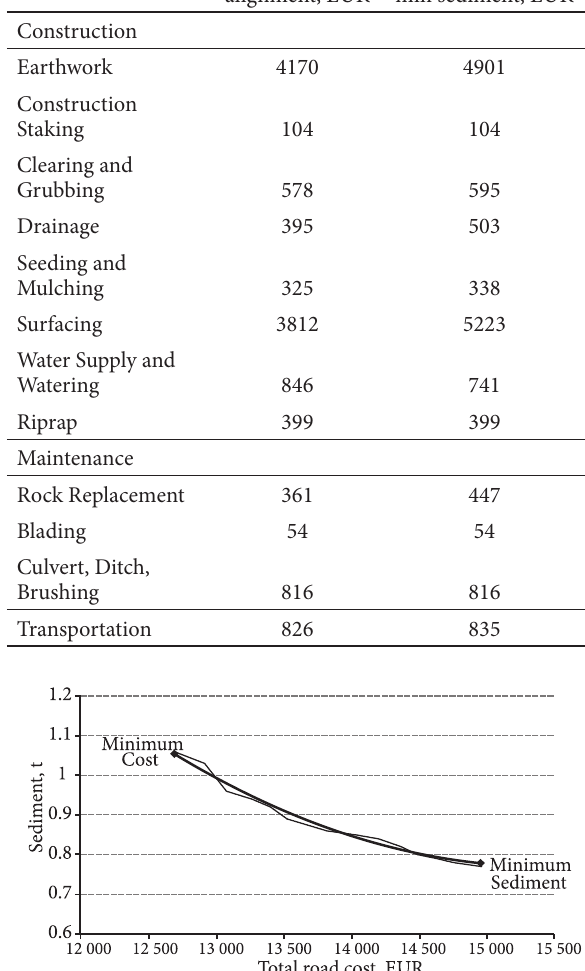
Fig. 5. The relationship trend between total road cost and sedimentation